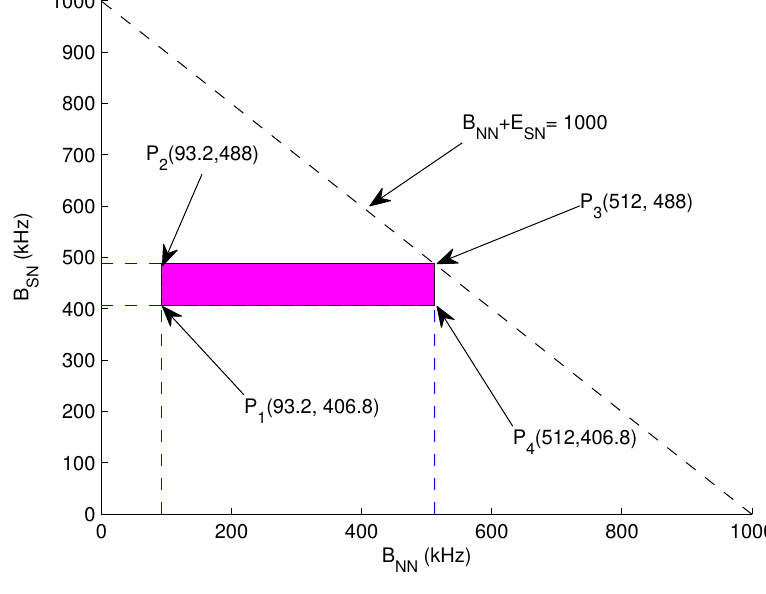
Figure 4. Feasible Region: